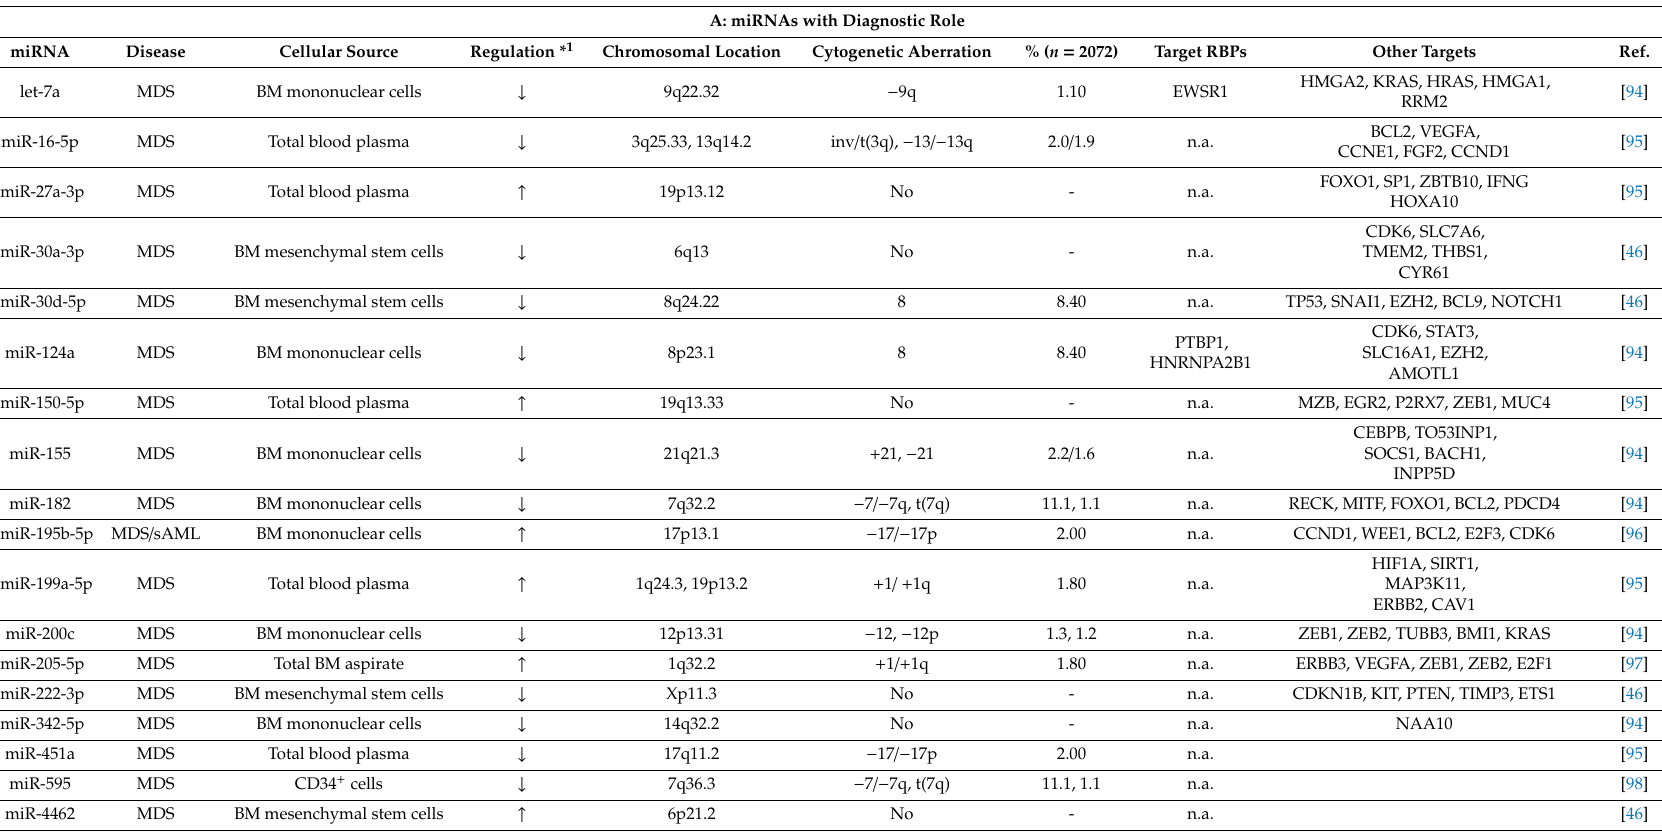
Table 1. Di ff erentially Expressed miRNAs, their Regulation, their Targeted RNA-Binding Proteins (RBPs) and Clinical Parameters in MDS and sAML. A: miRNAs with Diagnostic